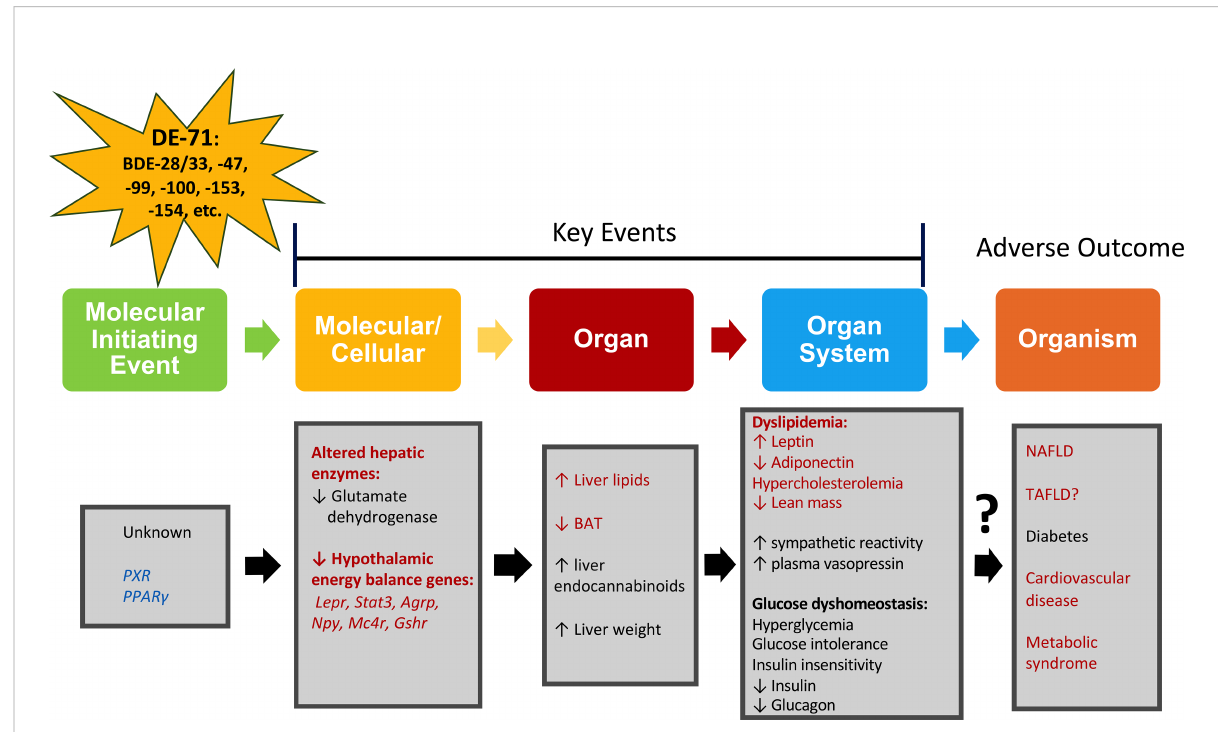
FIGURE 7 Adverse outcomes pathway (AOP) for metabolic alterations produced by DE-71. An AOP network portrays the plausible pathway from an initial perturbation by a penetrating toxicant called a molecular initiating event (MIE) to an adverse outcome, through different intermediate events called key events (KE) taking place at diverse levels of biological organization such as molecular, cellular, organ and organ system (93). Metrics evaluated are indicated in red (current study) and black (previously reported in (16, 57, 87). Four KEs leading to liver steatosis, diabetes, and metabolic syndrome are proposed: elevated hepatic lipid content, reduced expression of energy balance genes, increased plasma leptin, decreased plasma adiponectin. Blue text: MIE has not been determined but activation of pregnane X receptor (PXR) and peroxisome proliferator-activated receptors (PPAR g ) has been suggested as part of drug-induced liver injury and steatosis (88, 89, 93). Hypothalamic energy balance genes: Leptin receptor, Lepr ; Signal transducer and activator of transcription 3, Stat3 ; Agouti-related peptide, Agrp; Neuropeptide Y, Npy; Melanocortin-4 receptor, Mc4r; Growth hormone secretagogue receptor, Gshr; toxicant-associated fatty liver disease,